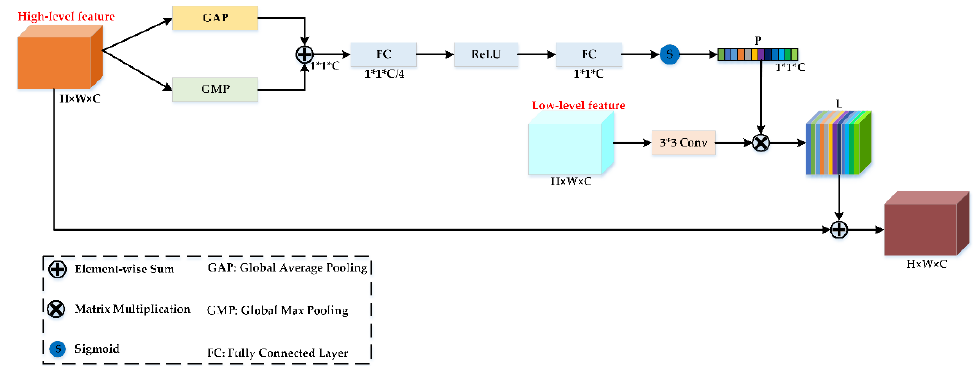
Figure 5. The schematic diagram of CSFEM.